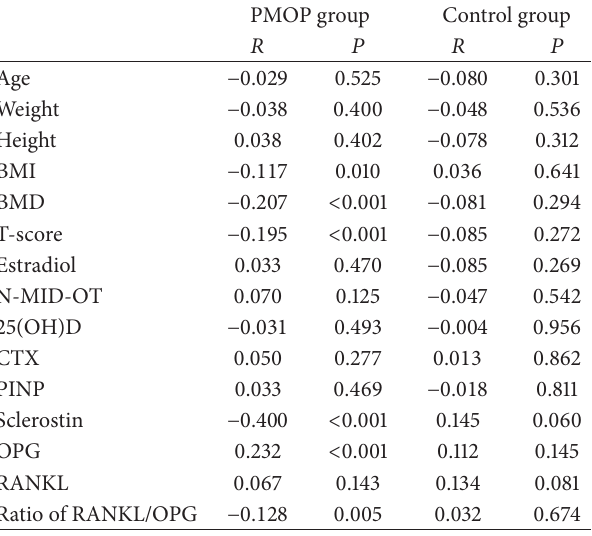
Table 2: Associations of serum 𝛽 -catenin with other parameters in PMOP group and control group. PMOP group Control